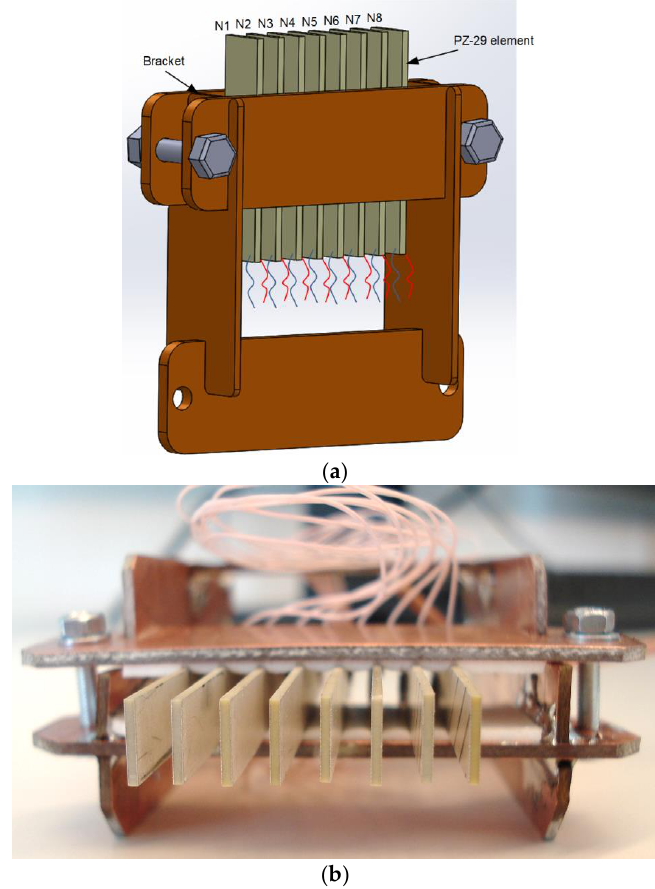
Figure 23. The prototype of the air-coupled 8 element array: ( a )—3D view, ( b )—top view.